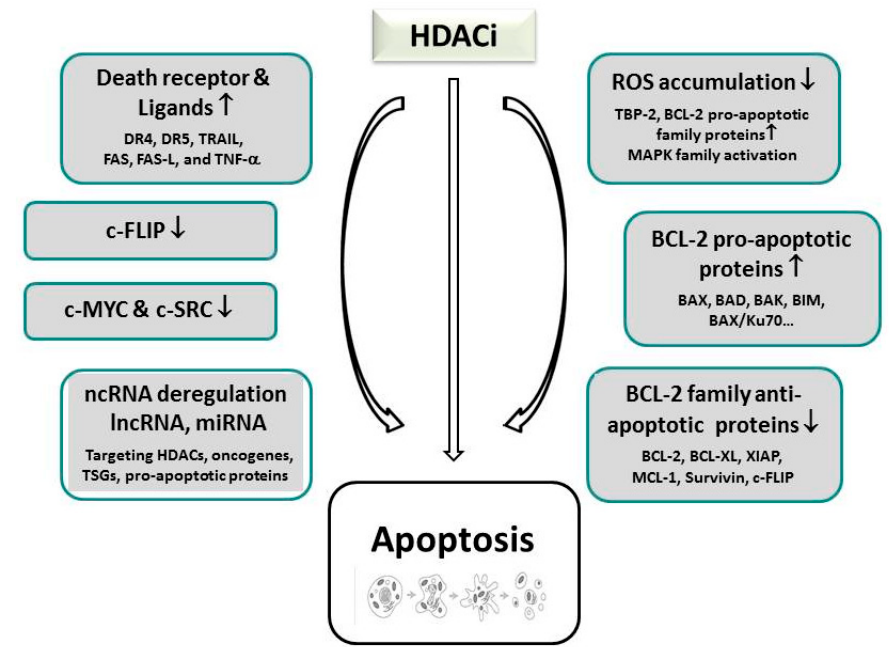
Figure 1. Known mechanisms of histone deacetylase inhibitor-induced (HDACi) re-activation of apoptosis. These activate the intrinsic (mitochondrial) the extrinsic (death-receptor) or both pathways of apoptosis. Also non-coding RNAs, of which microRNAs prevail, have been described to mediate HDACi-stimulated apoptosis.